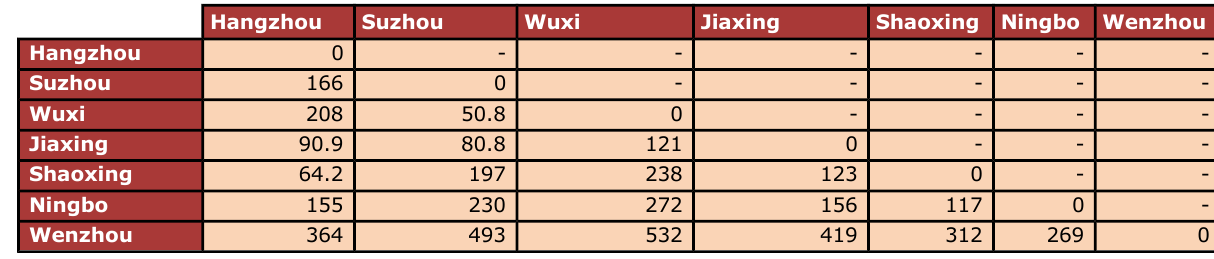
Table 2. Road Distance Between Some Cities (Unit: km)